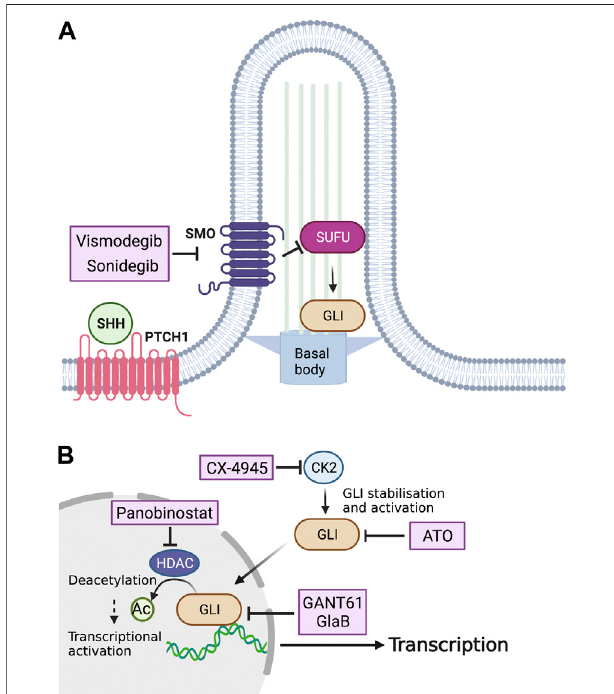
FIGURE 3 | Potential inhibitors of SHH signaling for the treatment of MBs. (A) Vismodegibandsonidegib,drugsthatinhibitSHHactivationbySMO on the surface of the tumor cell, have been approved for treating MB patients. (B) Inside the tumor cell, silmitasertib (CX-4945) blocks the kinase activity of CK2, which results in dephosphorylation of GLI proteins, while GANT61, ATO, and GlaB are capable of preventing GLI-mediated transcription. Panobinostat, an HDAC inhibitor, reduces GLI activity via regulation of its acetylation. CK2, Casein kinase 2; GANT61, GLI antagonist 61; ATO, Arsenic trioxide; GlaB, Glabrescione